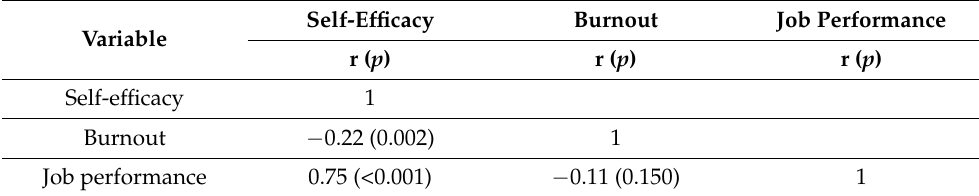
Table 3. Correlation among self-efficacy, burnout, and job performance ( n =